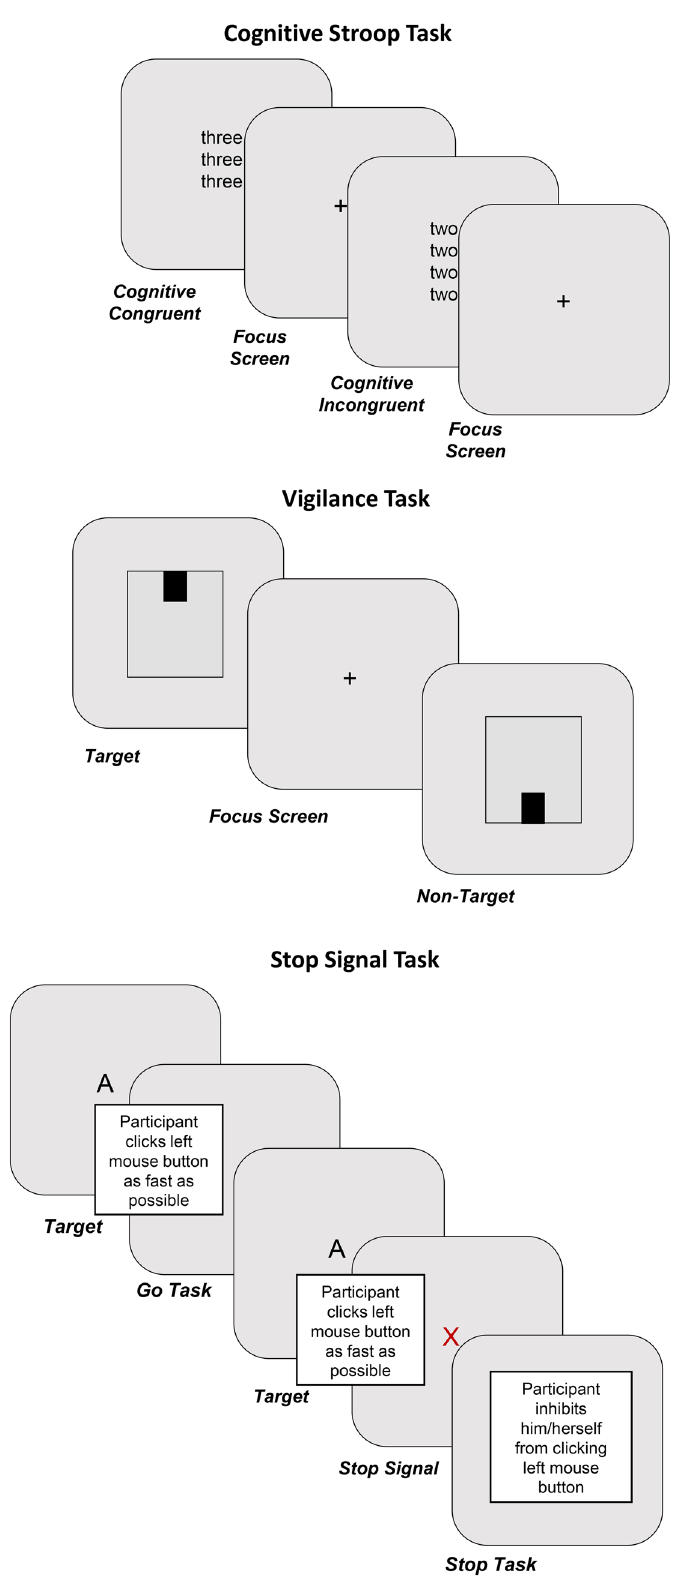
Figure 2. Schematic overview of the different tasks. ( A ) Cognitive counting Stroop task, ( B ) Vigilance task, and ( C ) Stop-Signal